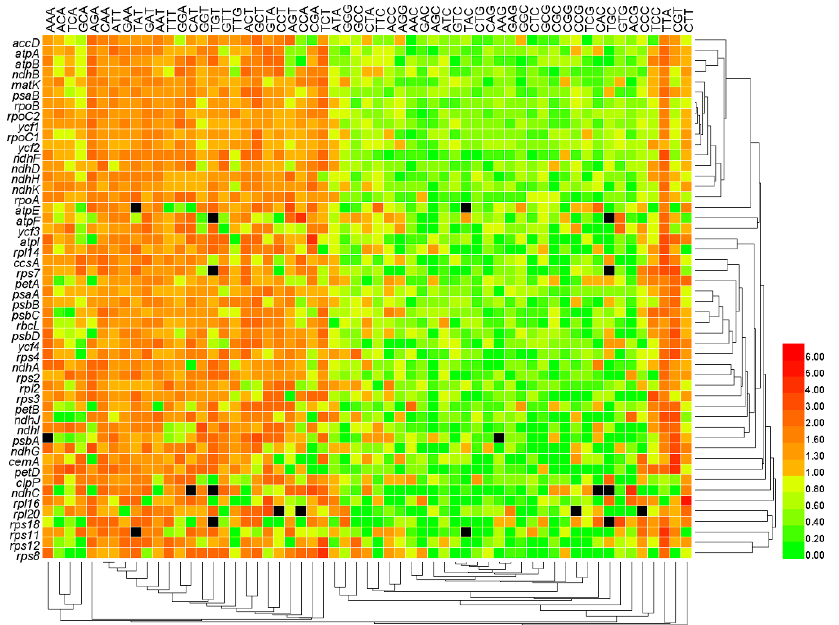
Figure 5. Heat map of codon usage preference based on mean RSCU values. Black cells in the heat map represent that the corresponding gene lacks the amino acid encoded by the corresponding codons. The numbers next to the legend represent RSCU values. Table 2. Statistics of A-, C-, G- and T-terminal codon usage based on RSCU values. Codon Bias